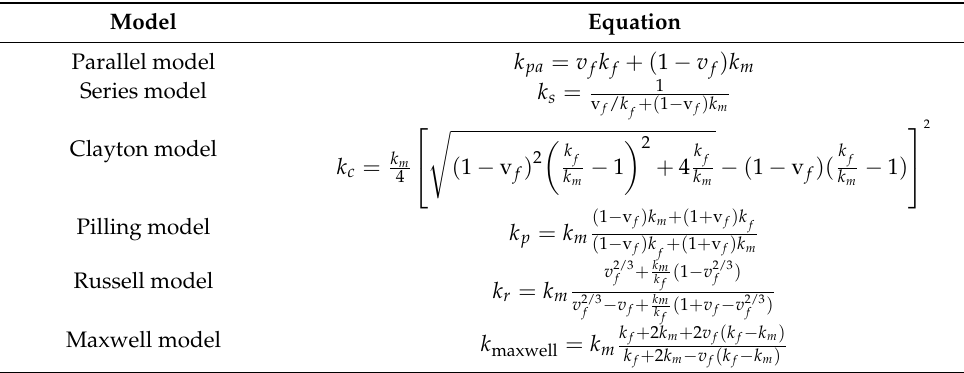
Table A1. Several calculation equations of theorical